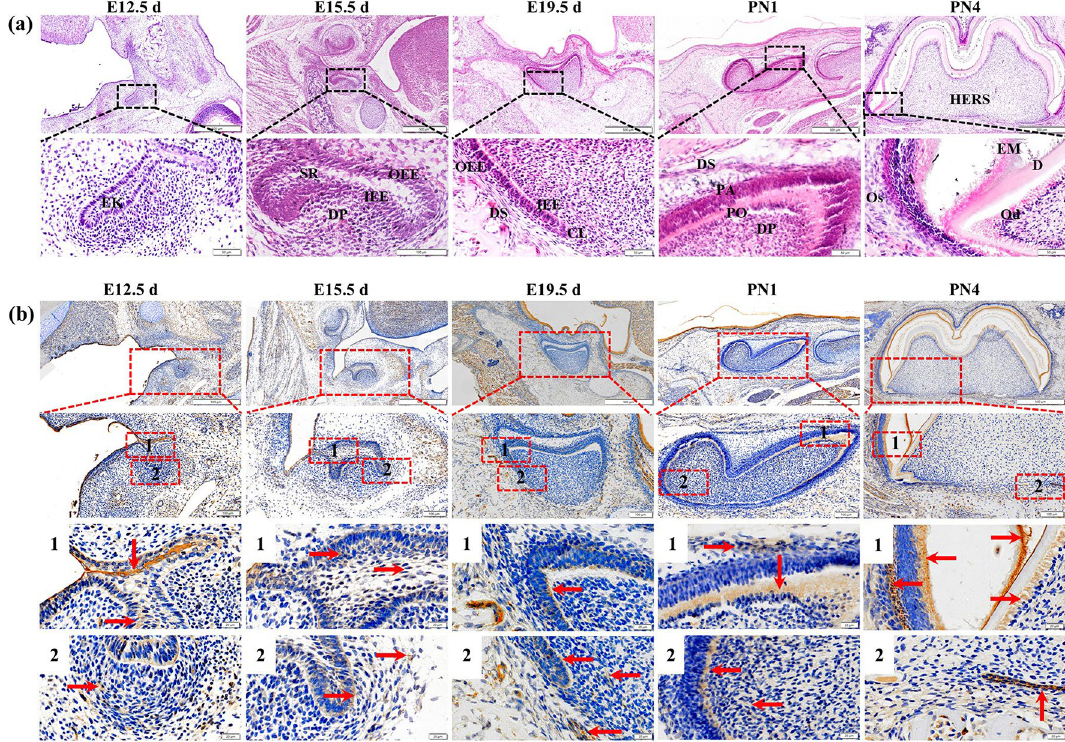
Figure 1. The results of HE staining and expression pattern of Mage-D1 in the stage of rat dental germ development. ( a ) HE staining of first molar in rat at E12.5 d, E15.5 d, E19.5 d, PN1, PN4. ( b ) Mage-D1 expression in first molar of rat at E12.5 d, E15.5 d, E19.5 d, PN1 and PN4 by immunohistochemistry (Red arrow indicates positive area). Scale bars: 50 μm or 500 μm. EK enamel organ, SR stellate reticulum, IEE inner